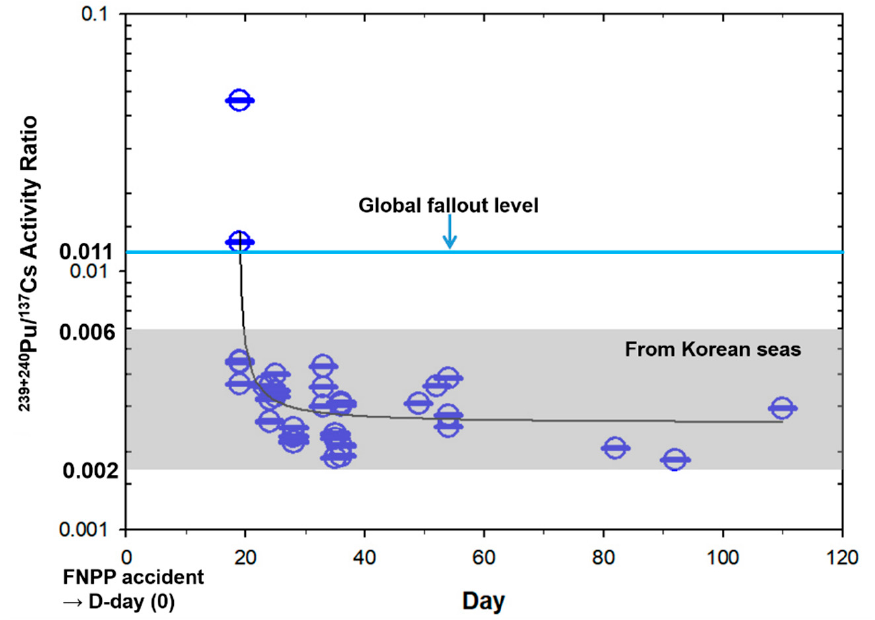
Figure 7. Distribution of the 239+240 Pu/ 137 Cs ratio over time after the Fukushima NPP accident (D-day = 0) in the Korean seas’ surface water.